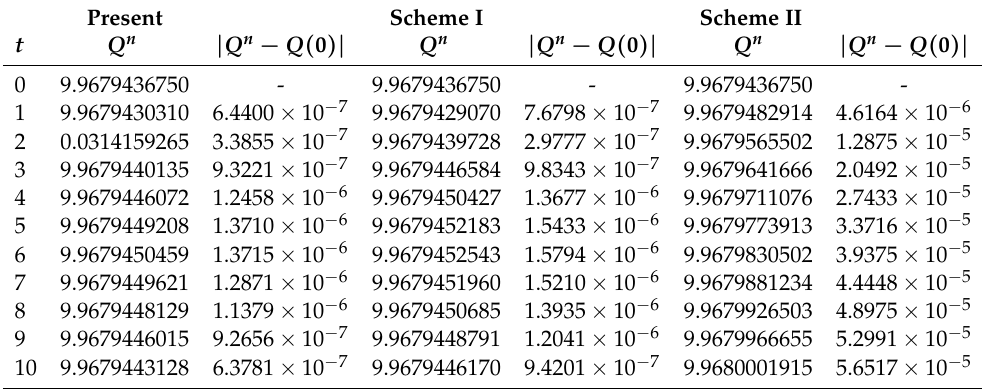
Table 4. The quantities of Q n and its errors using ∆ x = ∆ t = 1/8 at various